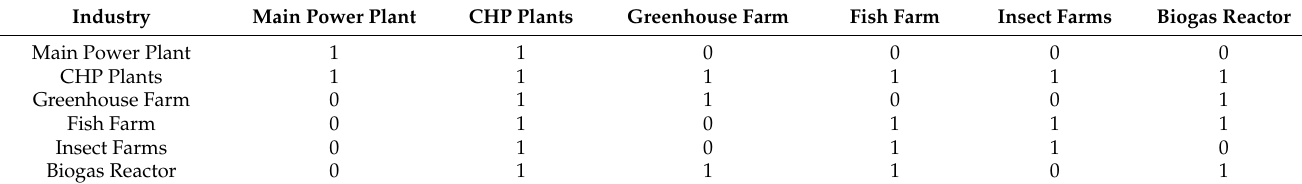
Table 2. IS network matrix